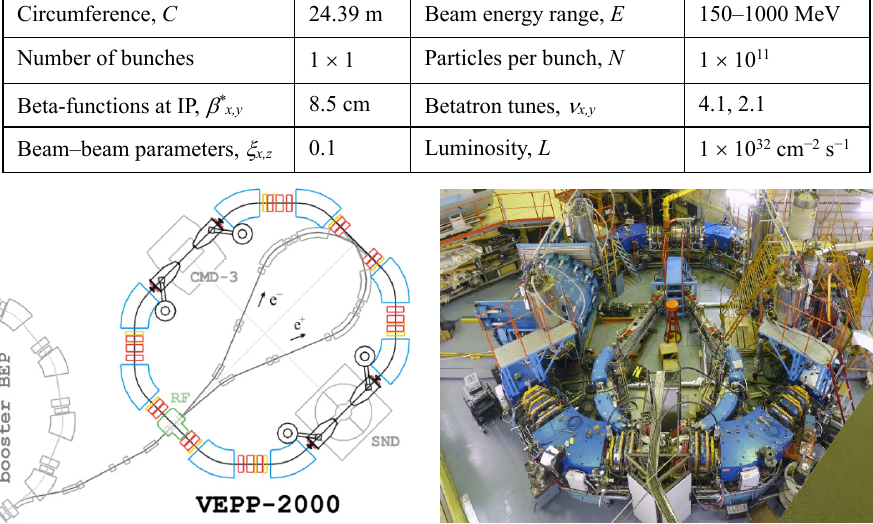
Table 3. VEPP-2000 main design parameters (at E = 1 GeV).